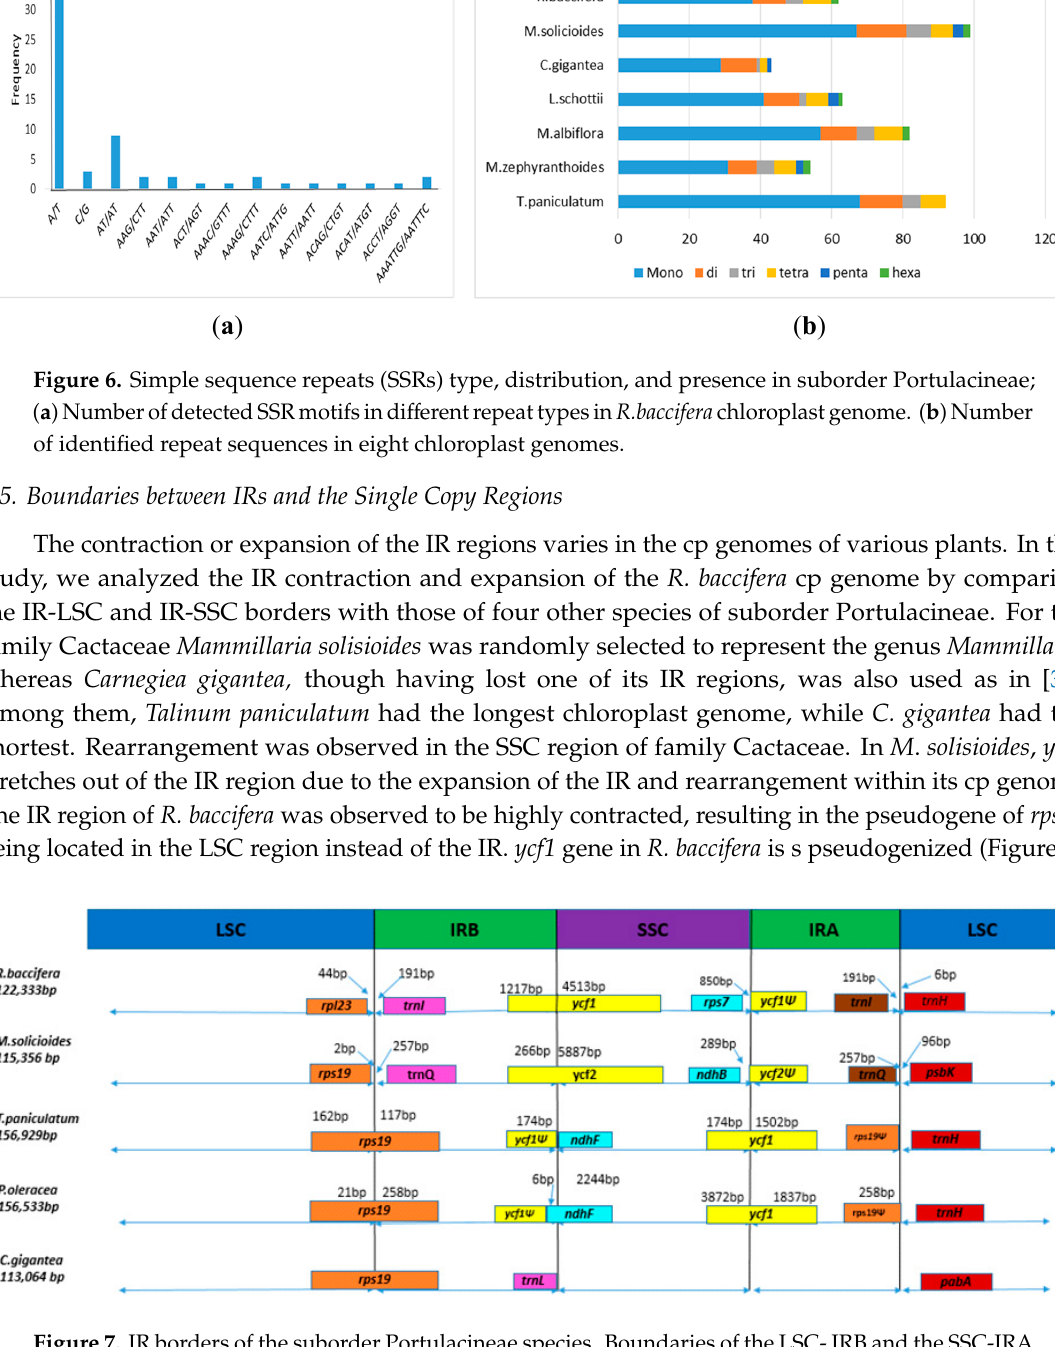
Figure 7. IR borders of the suborder Portulacineae species. Boundaries of the LSC- IRB and the SSC- IRA regions in suborder Portulacineae species. Genes with the symbol Ψ are pseudogenes .